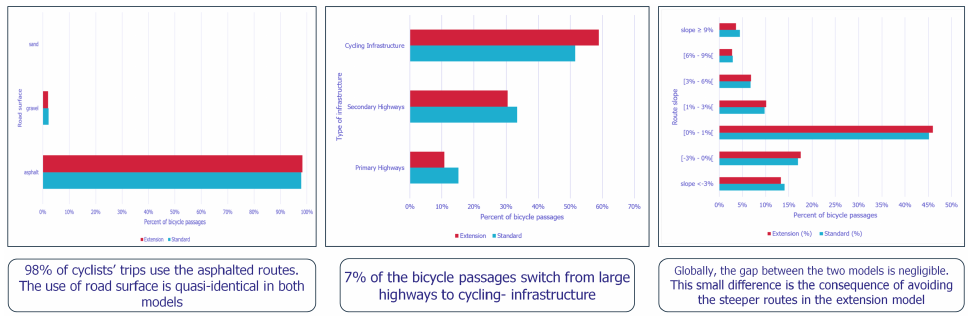
Figure 7. MATSim bicycle standard (blue) and extension (red) models: extraction of simulation results.